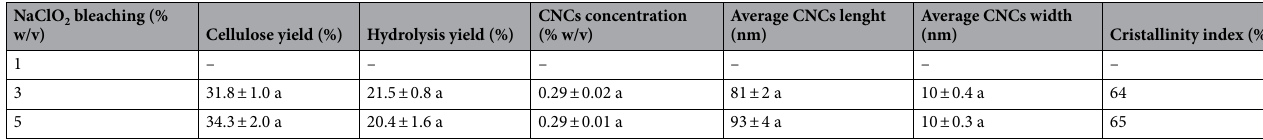
Table 1. Cellulose yield (%), hydrolysis yield (%), CNCs concentration (%), Average CNCs length and width (nm), Cristallinity index for the three cellulose extraction protocols differing for the sodium chlorite concentration (1, 3, 5% w/v) employed for the bleaching step. “–” means that was not possible to obtain pure cellulose, thus CNCs were not synthesised from the lignocellulosic matrix obtain by using bleaching at 1%. No statistical differences were recorded. “± value” refers to standard deviation between three replicates. All the data come from the average of three independent